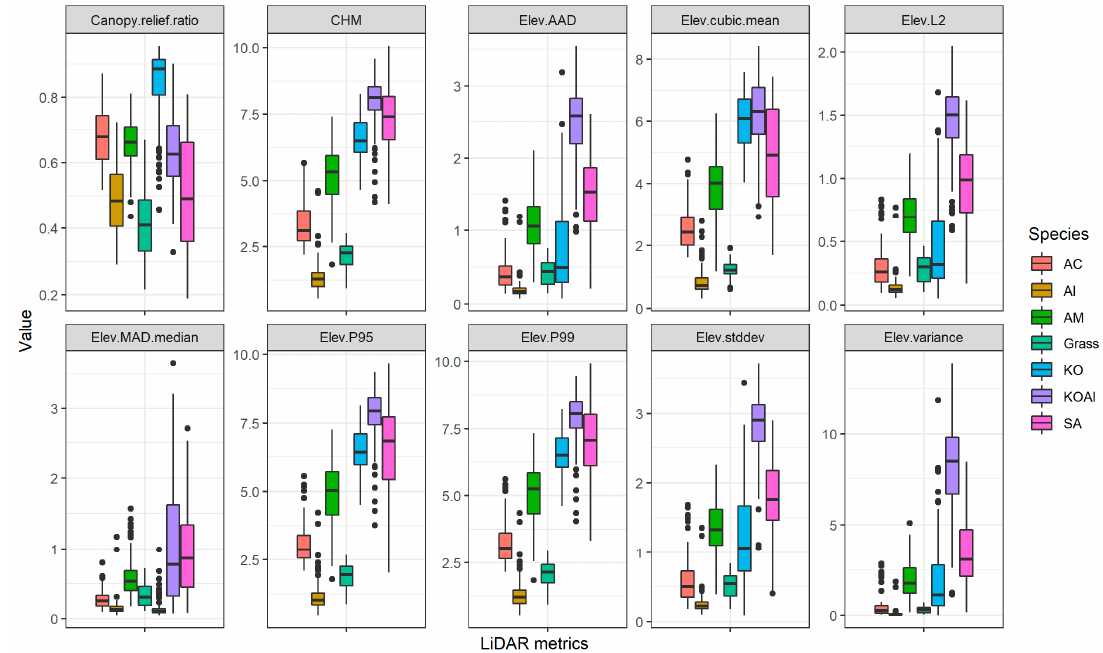
Figure 4. Di ff erence among species in 2 m-grid LiDAR elevation Figure 4. Difference among species in 2 m-grid LiDAR elevation metrics.